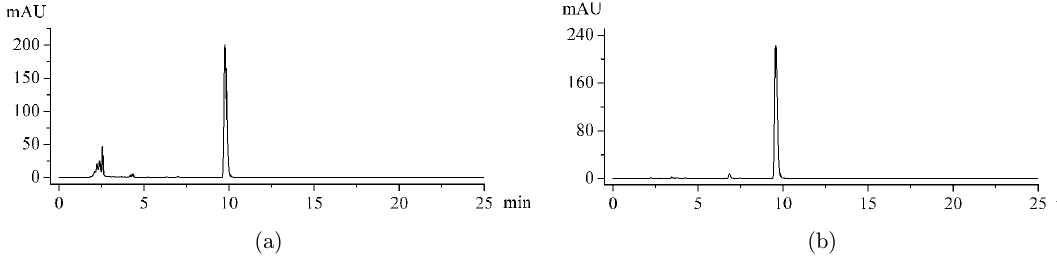
Fig. 3. HPLC chromatograms of berberine in PC. (a) Extract of PC sample and (b) Standard solution.